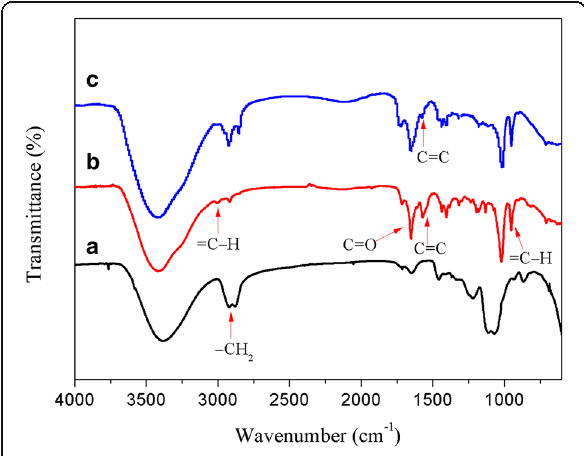
Fig. 2 FTIR spectra of a HPG, b HPG-MA, and c